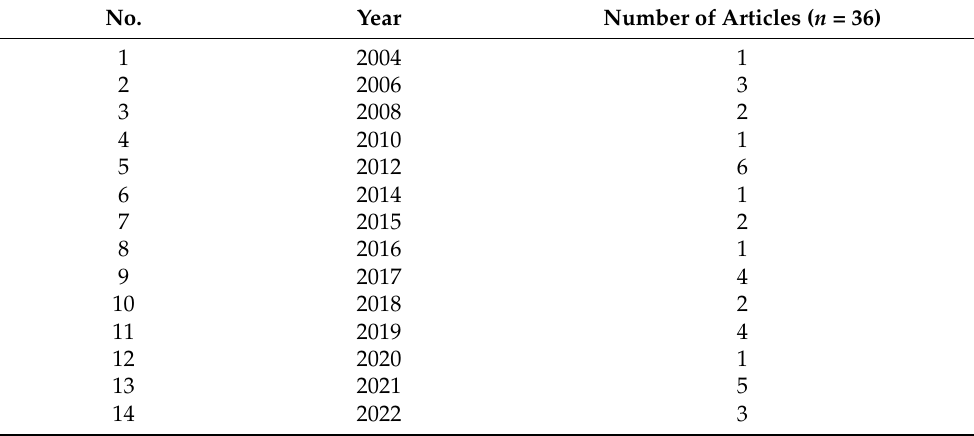
Table 2. Number of articles based on the study years.